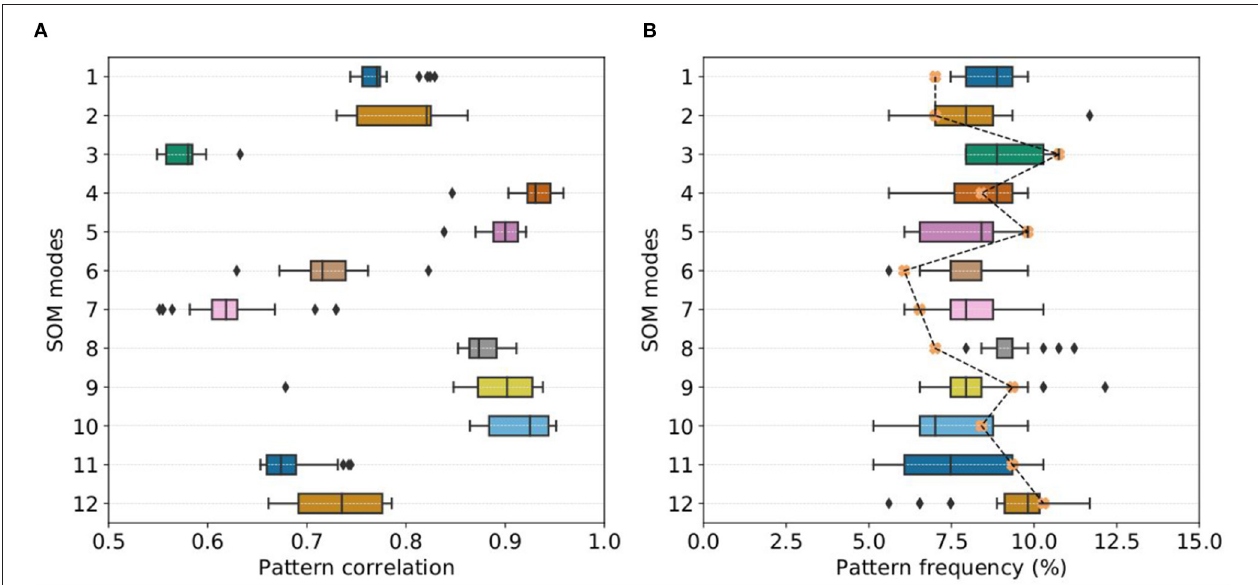
FIGURE 3 | Model agreement with reanalysis: (A) Pattern correlation between observed and simulated SOM modes (per ensemble member). (B) Associated frequency of observed and simulated SOM modes (per ensemble member). X markers and dashed lines represent observed frequencies.